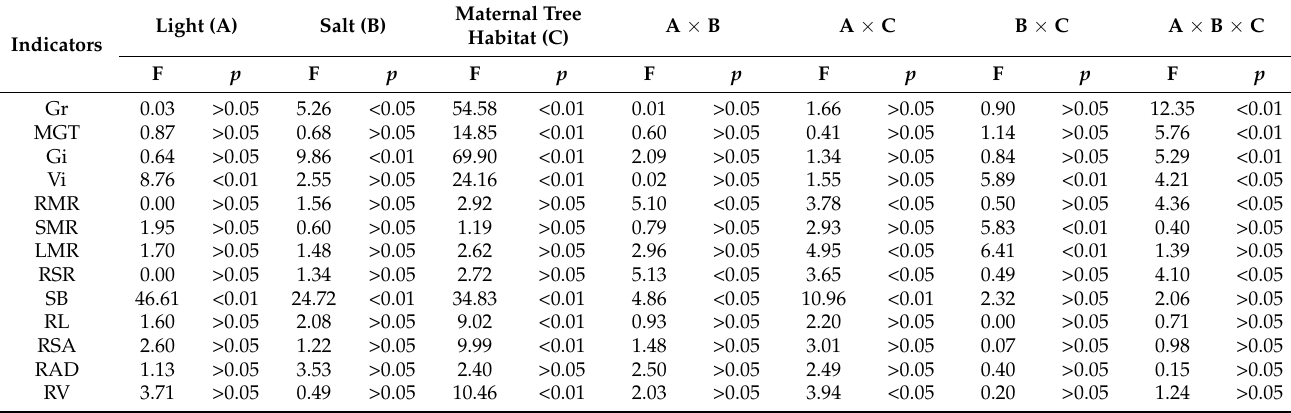
Table 3. Three-factor variance analysis table of light intensity, soil salt content, and maternal tree habitat of Morus alba on seed germination and seedling growth. Gr: germination rate; MGT: mean